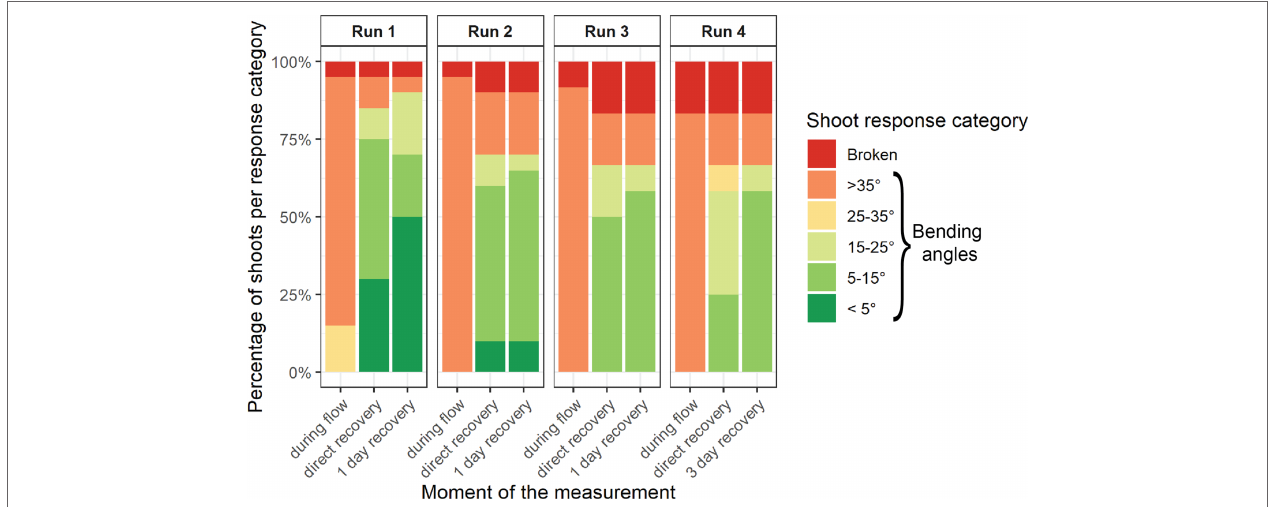
FIGURE 5 | Percentage of the reed shoots (n = 20 for run 1 and 2; n = 12 for run 3 and 4) that show a response in terms of breaking and bending angle when exposed to high flow velocities. The response was quantified in six response categories (broken shoots, and 5 shoot bending angles) and was measured at three moments in time (during the flow, directly after the flow stopped, 1 day later after runs 1-3 and 3 days later after final run 4).